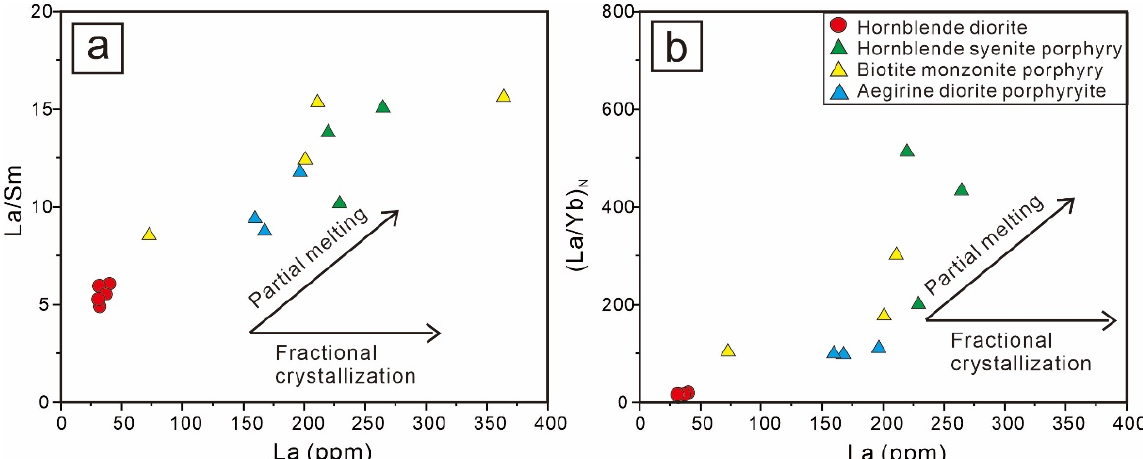
Figure 11. ( a ) La versus La/Sm and ( b ) La versus (La/Yb) N diagrams for the Longbaoshan alkaline complex showing partial melting and fractional crystallization, modified after [81].